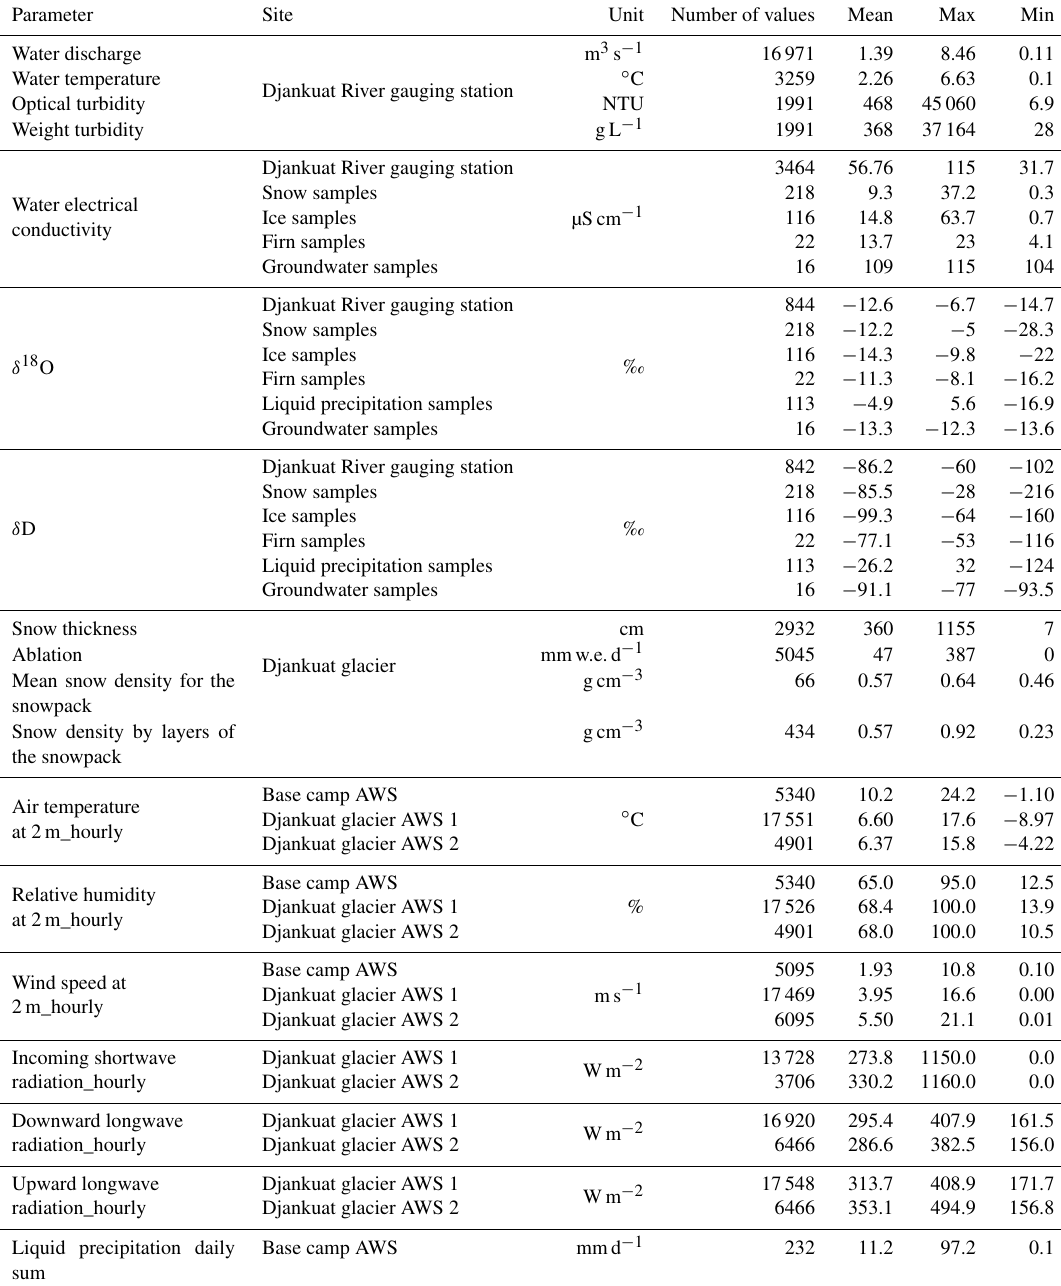
Table 3. Mean value and range of some of the parameters measured in the Djankuat research basin. Parameter Water discharge